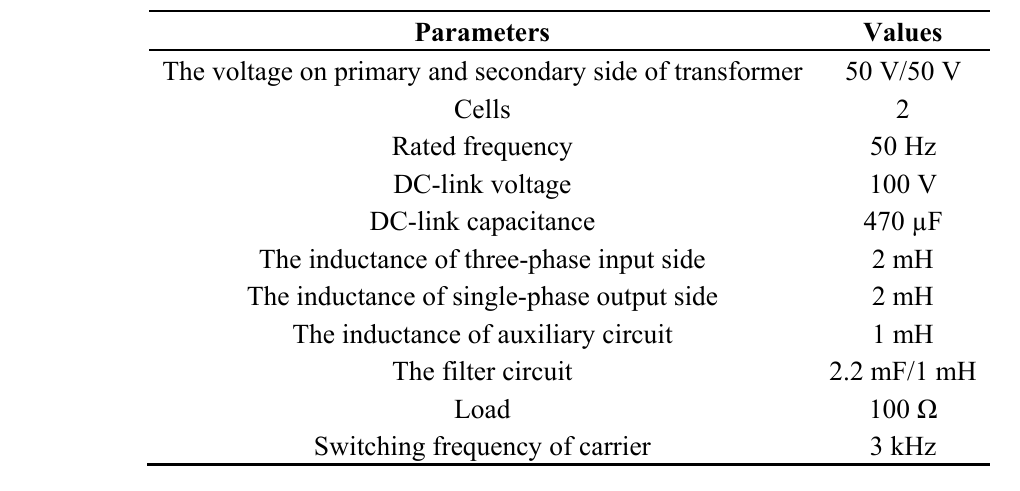
Figure 13. Photo of the experimental prototype. Table 2. Experimental circuit parameters.